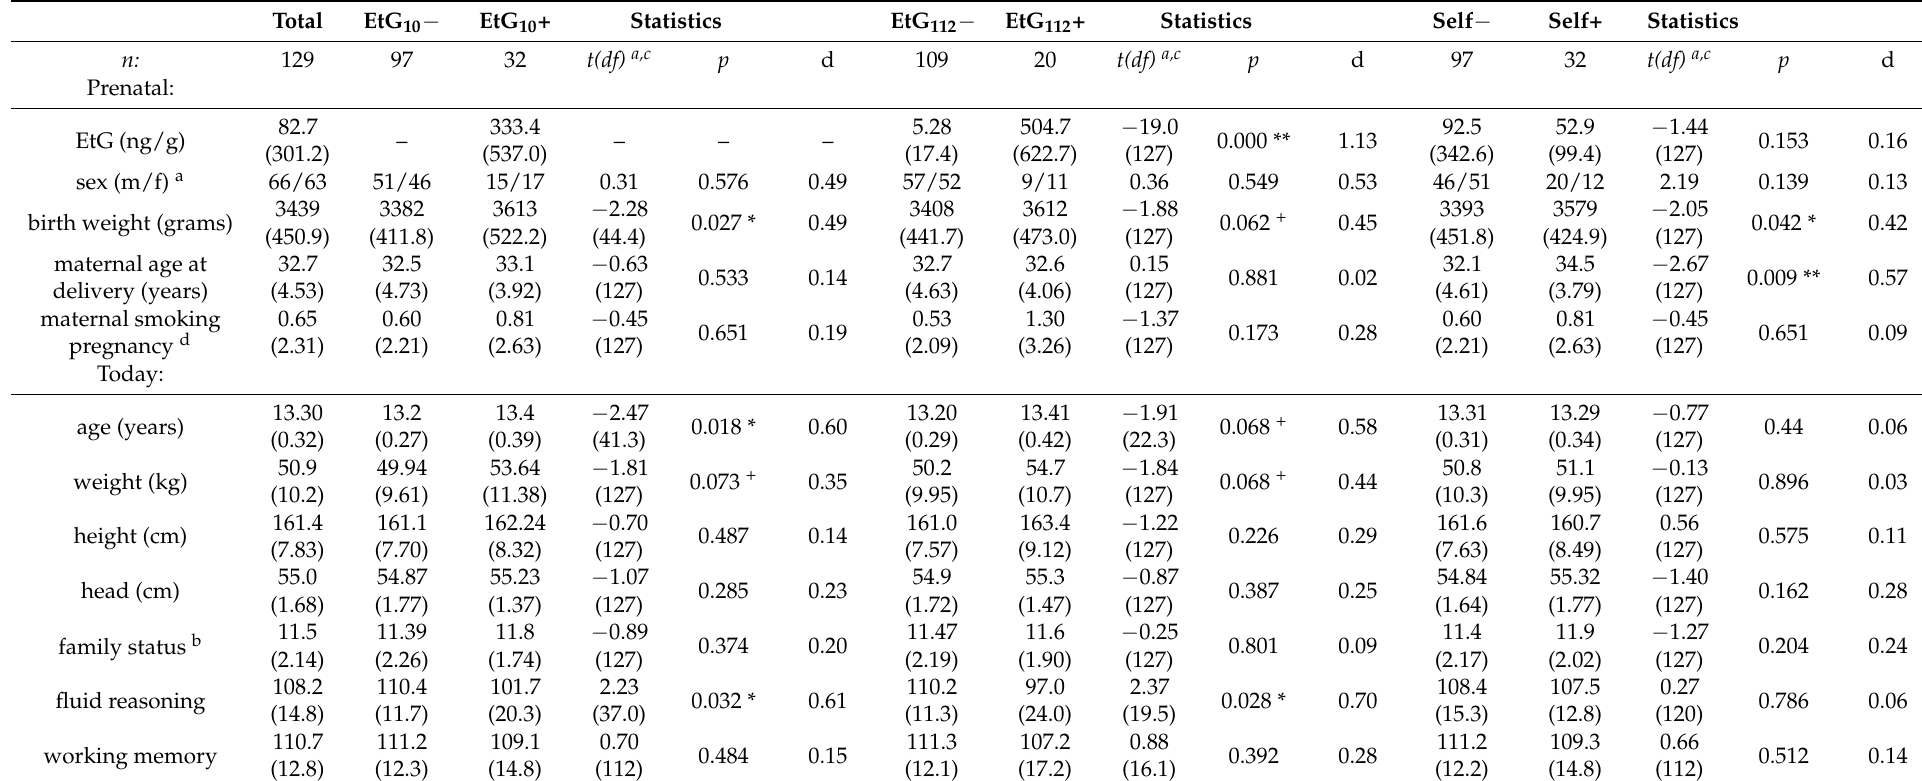
Table 1. Frequency ( n ), means (M), and standard deviations (SD) of sample